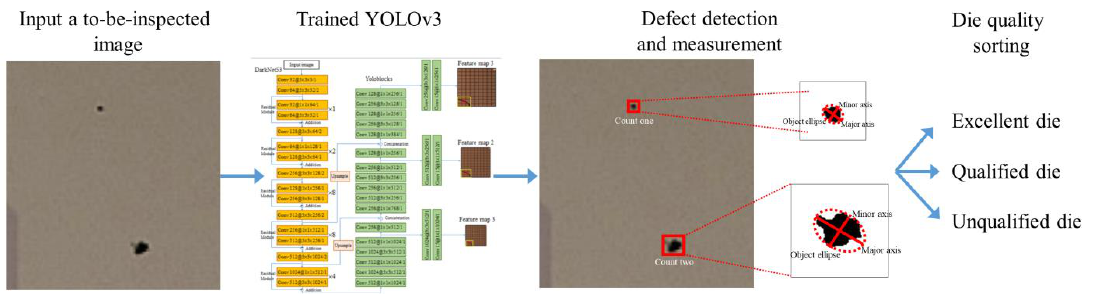
Figure 4. Die defect detection and measurement.